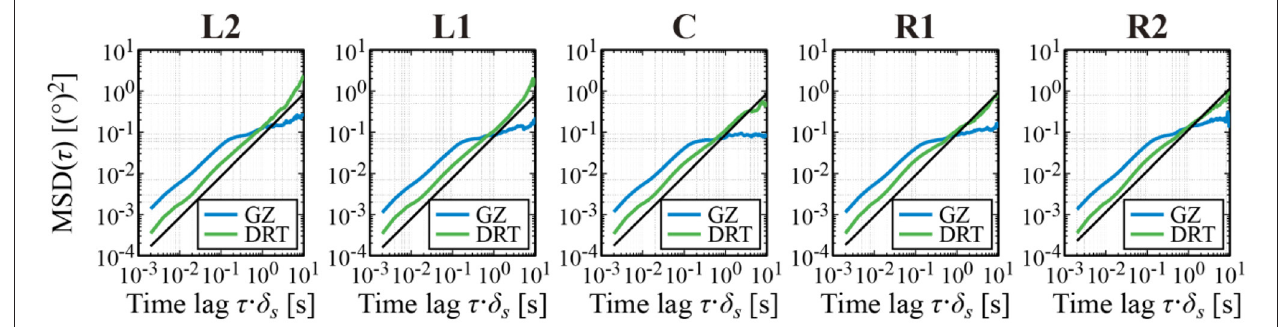
FIGURE 5 | Mean square displacement (MSD) analysis of the GZ and DRT time series. The blue and green curves represent, respectively, the MSDs of the GZ and DRT time series. The black lines are the MSD of the Brownian motion for comparison. The MSD curves depicted in each panel are the ensemble average of MSD for each sample path of a representative subject.